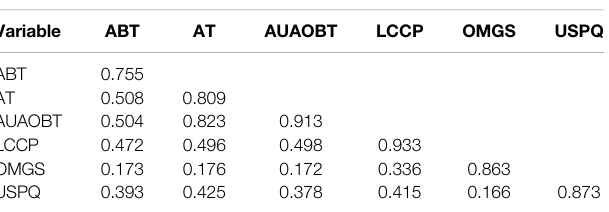
TABLE 5 | Discriminant validity using the heterotrait – monotrait ratio